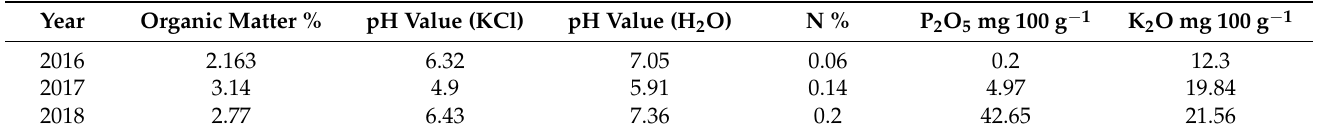
Table 3. Soil characteristics in three years, Zemun Polje, Belgrade.